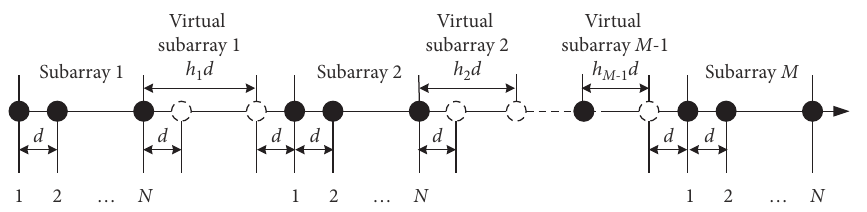
Figure 1: Geometry structure of